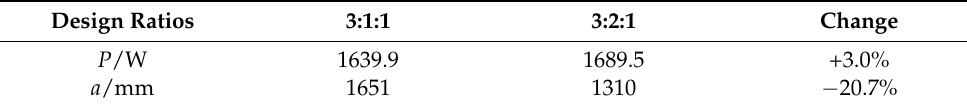
Table 2. Comparison of tank parameters under different design ratios.